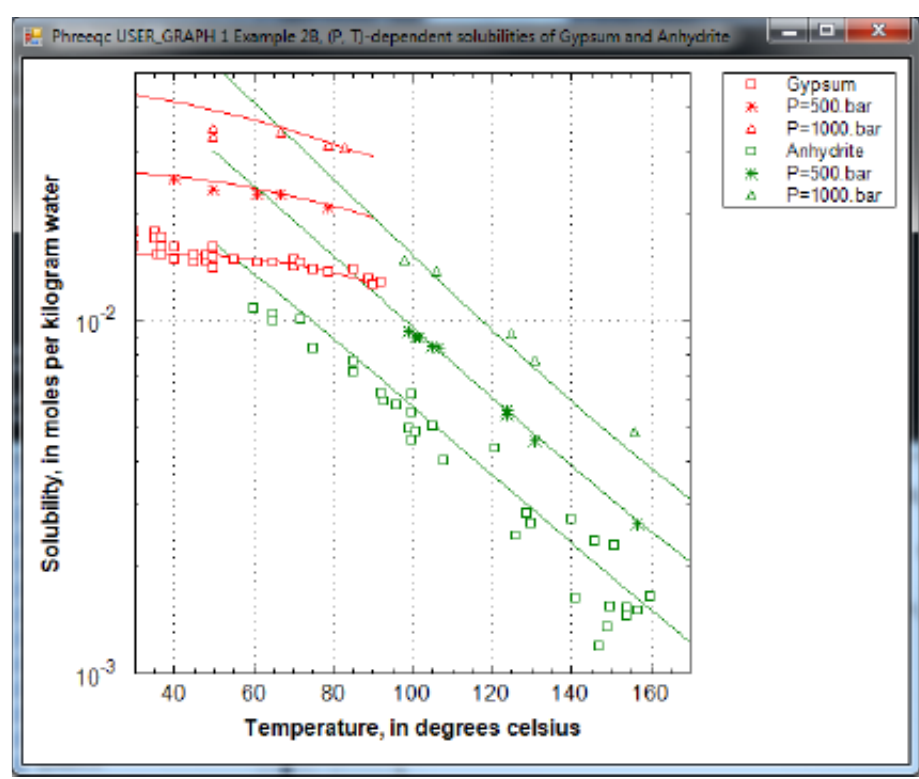
Figure 5. The solubility of gypsum and anhydrite as a function of temperature at 1, 500, and 1,000 bars. Data points from Blount and Dickson (1973); lines calculated by